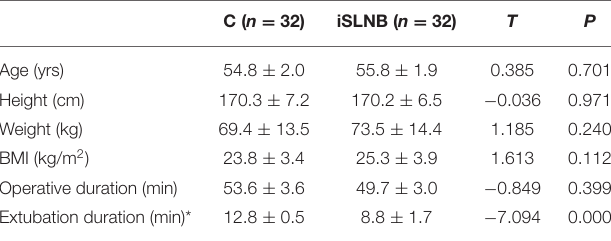
TABLE 2 | The demographic data, operative duration and tracheal extubation duration in two